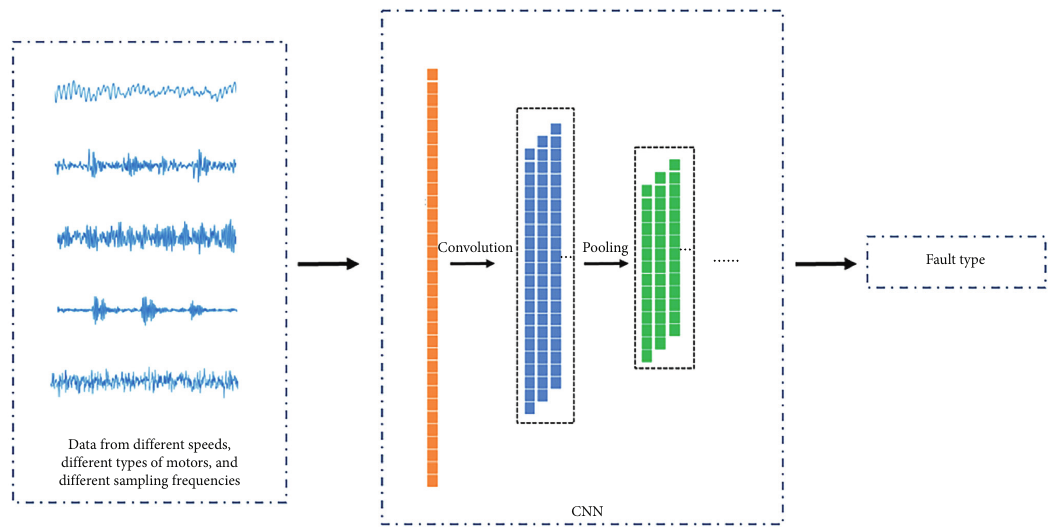
Figure 7: The network structure of generalization ability research.